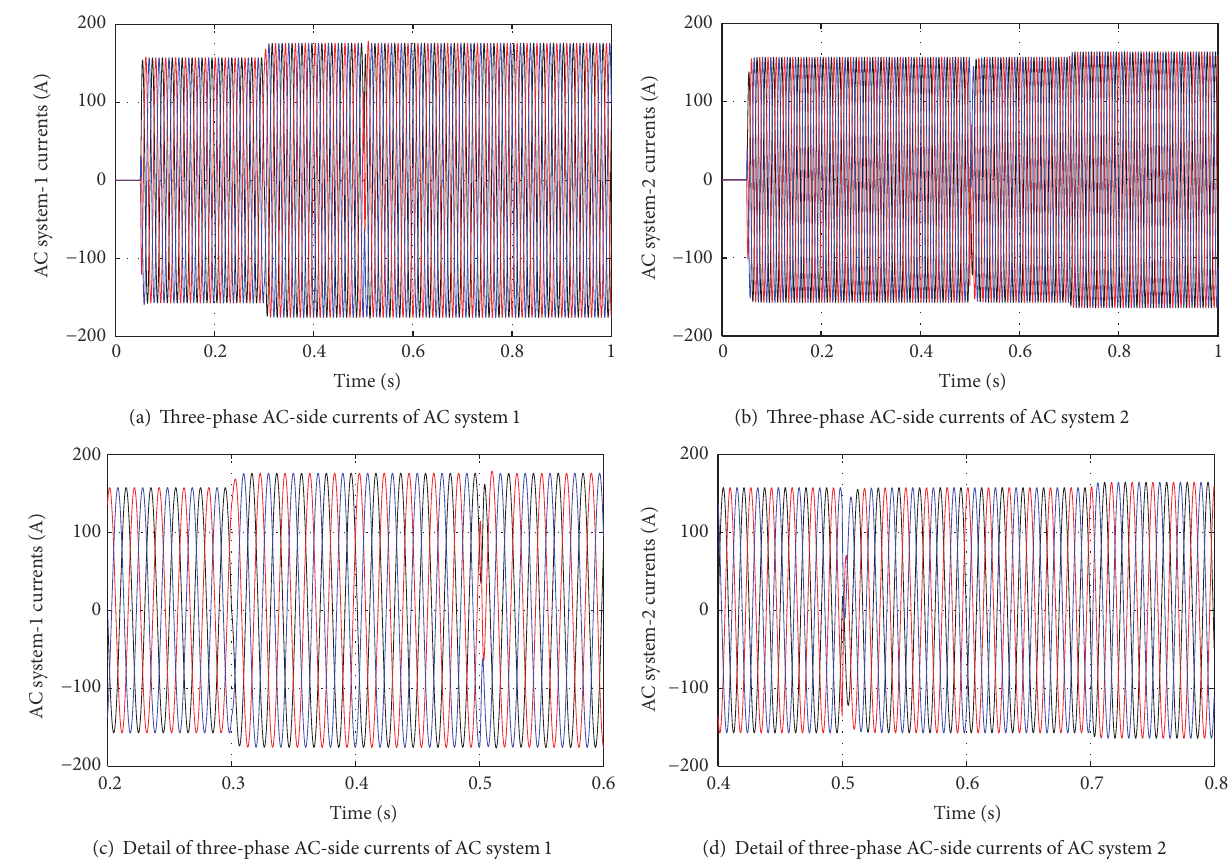
Figure 6: Three-phase AC-side currents via command-filter backstepping controller.